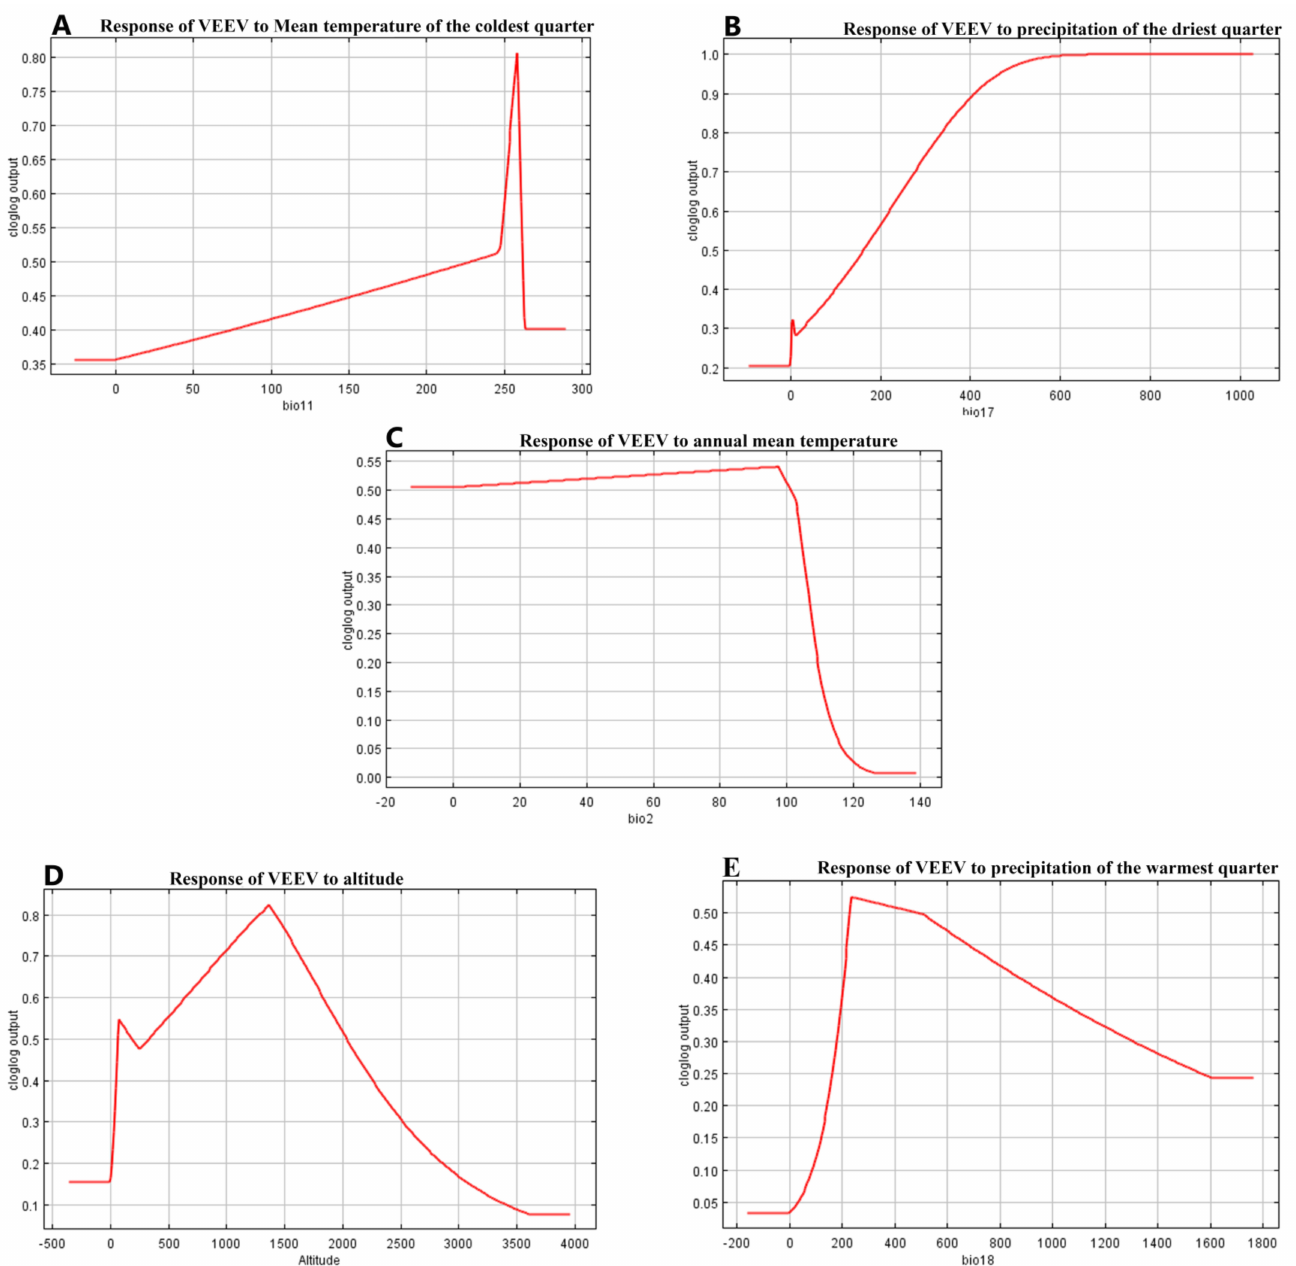
Figure 1. Shows the effect of each individual variable, that most contribute to the suitability of VEEV cases, when the remaining variables are configured to their average value. In ( A ), Bio11 Mean Temperature of the coldest quarter, the X -axis represents Degrees Celsius by 10, ( B ) Bio17 Precipitation of the driest quarter the units are millimeters of precipitation, ( C ), Bio 2 Annual mean temperature the units are Degrees Celsius by 10, ( D ) X -axis units are millimeters above sea level, and ( E ) units are millimeters of